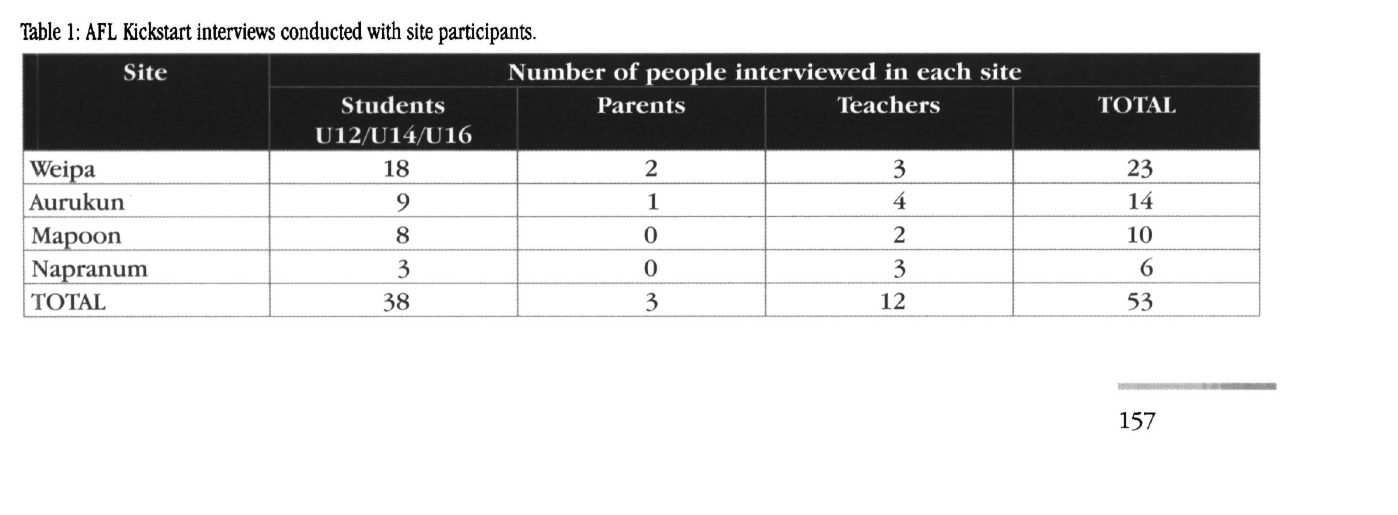
Table 1: AFL Kickstart interviews conducted with site